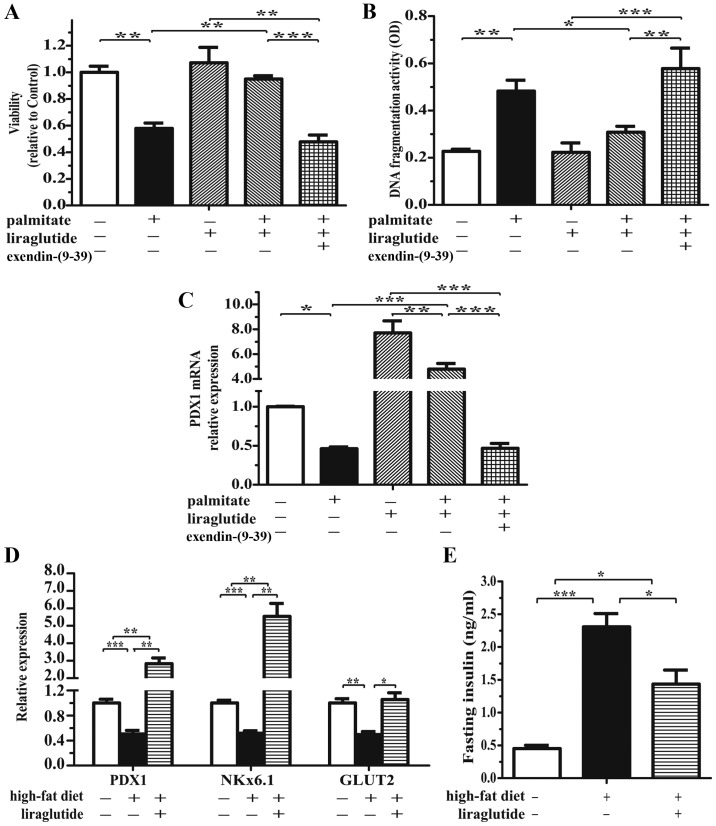
The glucagon-like peptide-1 receptor (GLP-1R) signaling agonist, liraglutide, attenuates lipotoxicity-induced islet dysfunction. Isolated non-diabetic islets were pre-treated with 100 nmol/l liraglutide and/or 0.5 µmol/l exendin-(9-39) for 2 h, followed by exposure to 0.5 mmol/l palmitate for 48 h. Islet (A) viability (detected by MTT assay) and (B) apoptosis (determined by examining histone-associated DNA fragments), and (C) pancreatic duodenal homeobox 1 (PDX1) mRNA levels (detected by qPCR). n=3 separate islet preparations. (D) After 8 weeks on their respective diets, the mRNA expression of PDX1, glucose transporter 2 (GLUT2) and Nkx6.1 was detected in the pancreata of the mice. (E) The plasma insulin levels were detected by insulin enzyme-linked immunosorbent assay (ELISA). n=6–7 mice/group; *p<0.05; **p<0.01; ***p<0.001.